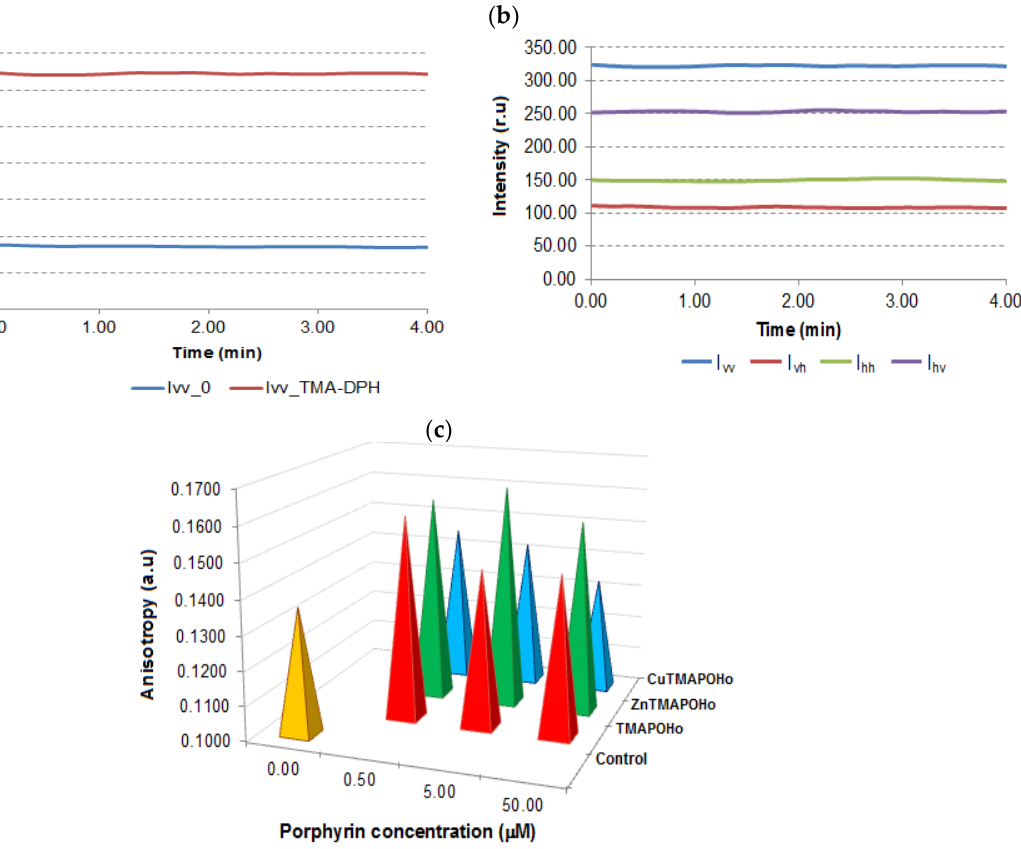
Figure 3. Investigation of the effects of porphyrinic compounds on membrane anisotropy. ( a ) — Intensity of signals obtained in Time Drive mode for U937 cells labelled with TMA-DPH vs. unlabeled cells; ( b ) — Intensity of response signals obtained in Time Drive mode for TMA-DPH-labelled cells; ( c ) — The effect of porphyrinic compounds (24 h incubation time and 0.5 µM, 5 µM, 50 µM concentrations) on the membrane anisotropy of U937 cells. Data of a representa- tive experiments are